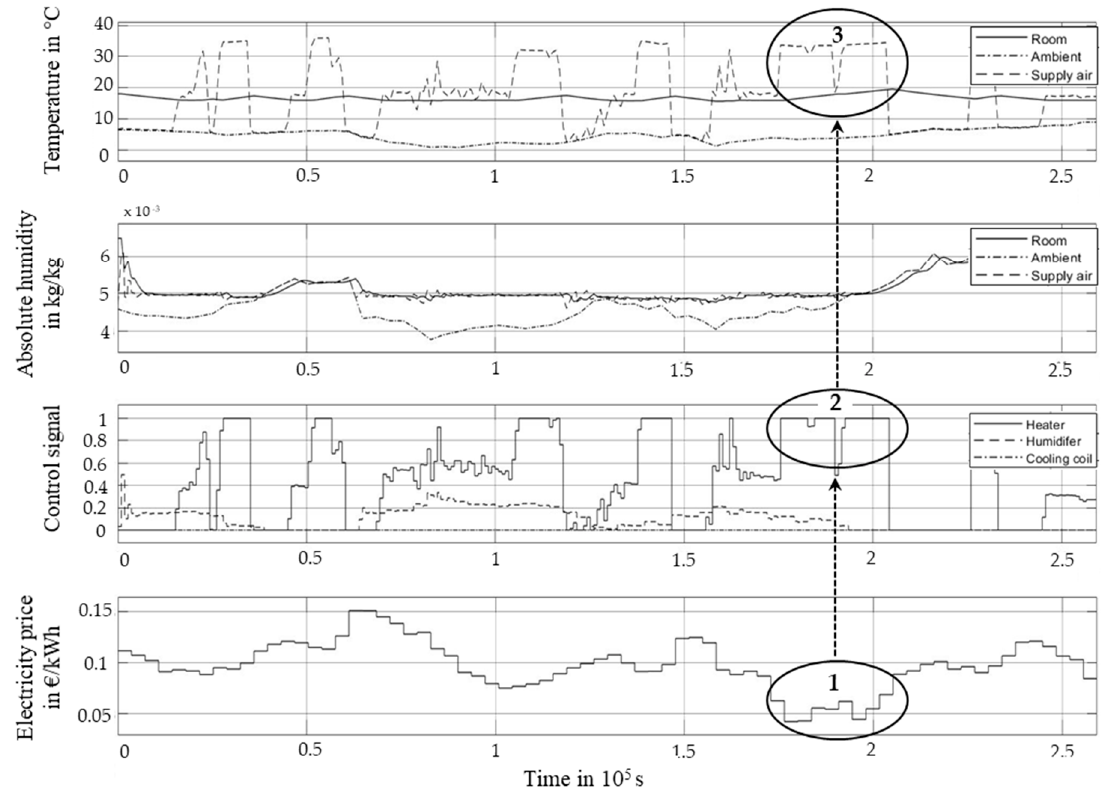
Figure 6. Cost-optimised EMPC with flexible electricity price over three days in January.